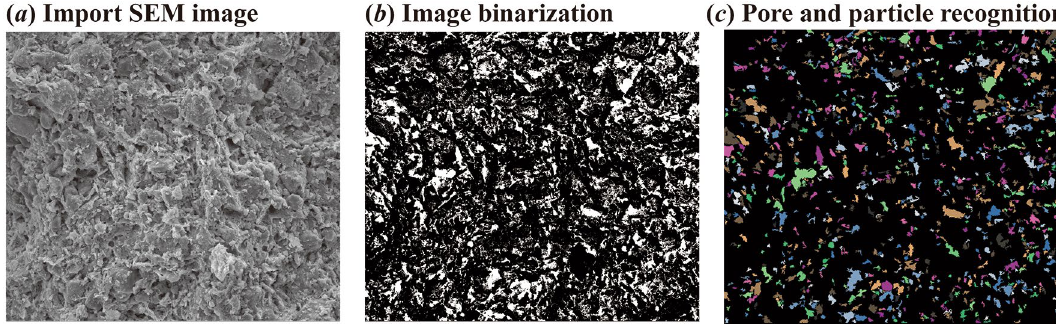
Figure 7. Pores and particles identification and analysis process by PCAS